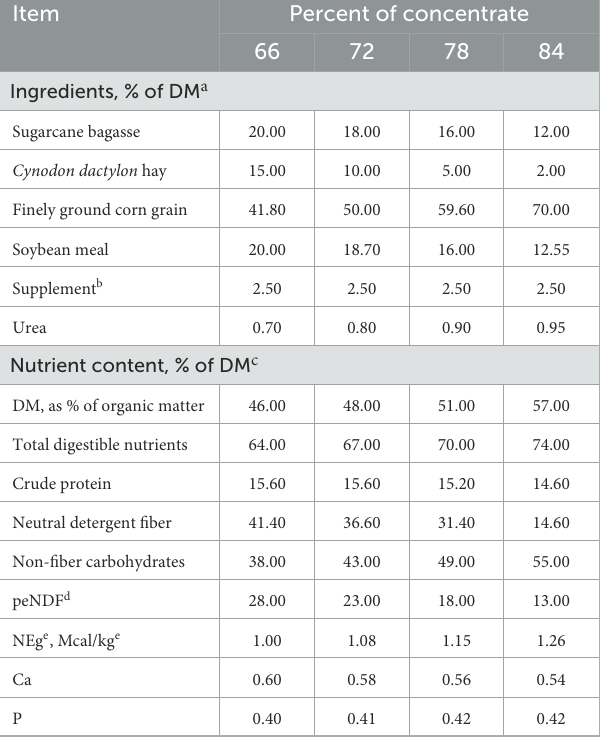
TABLE 1 Feed ingredients and chemical composition of high-concentrate diets fed to Nellore yearling bulls during adaptation and finishing